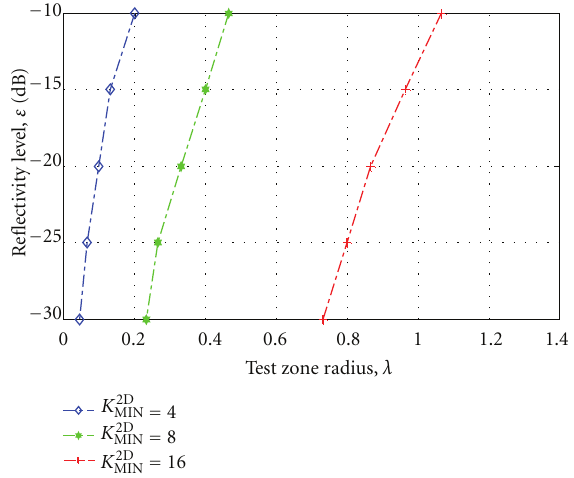
Figure 4: The equivalent reflectivity level as a function of the test zone radius for di ff erent number of probes for a single-polarized probes in 2D case.